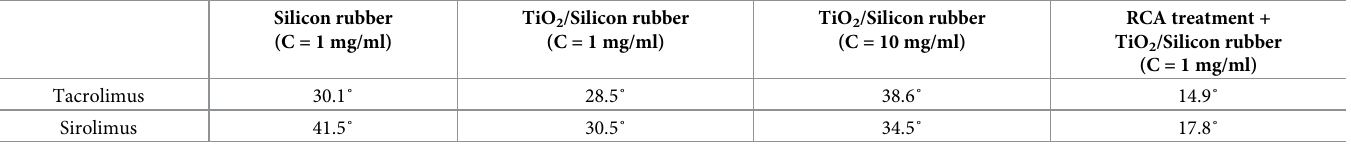
Table 1. Contact angles of dissolved drugs on the silicon with different drug concentrations and coating methods.